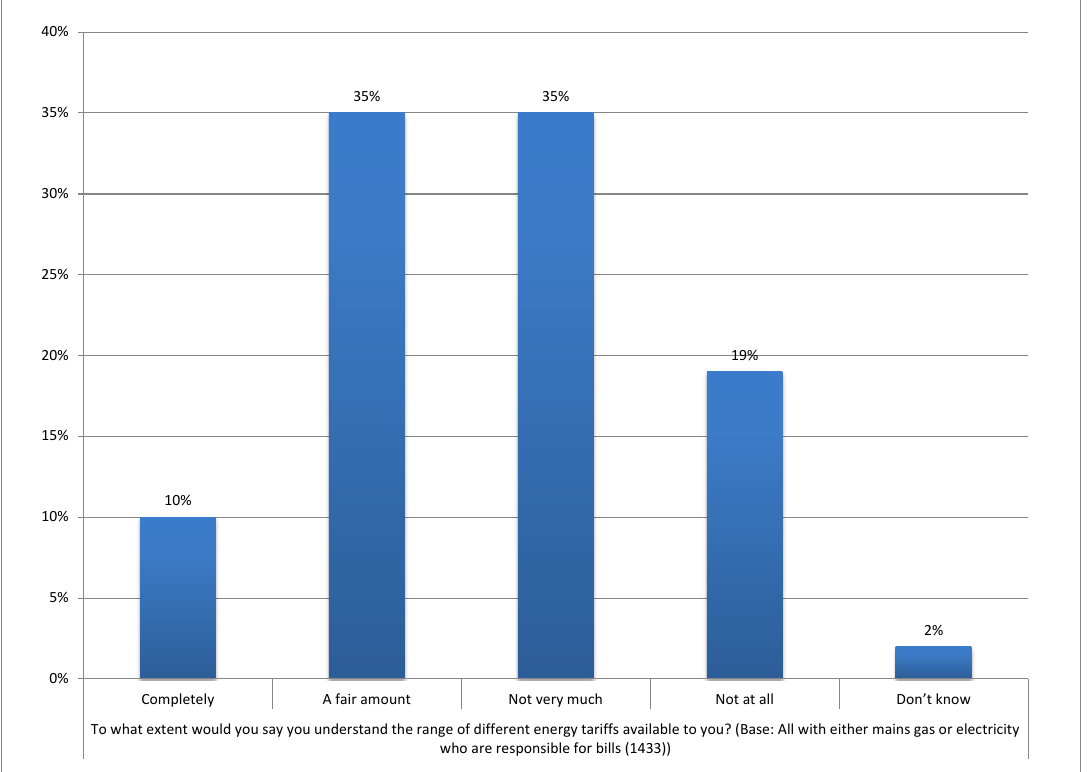
Figure 8: Consumer attitudes to tariff choices in 2013: understanding